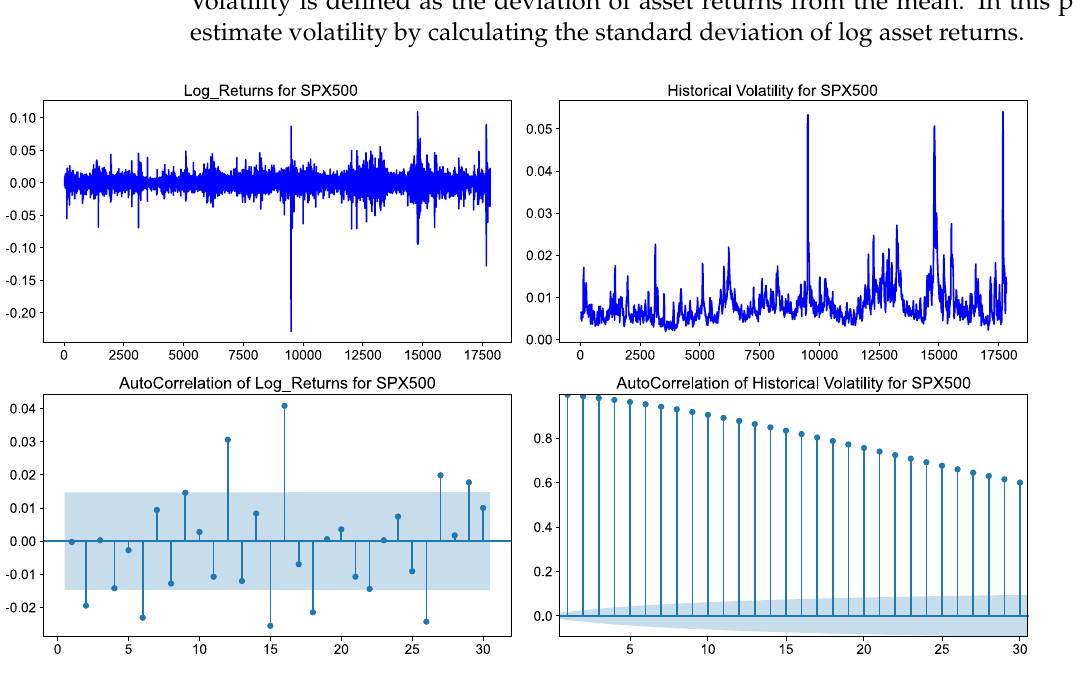
Figure 6. SPX500 Logarithmic return, historical volatility, and autocorrelation graphs. 452